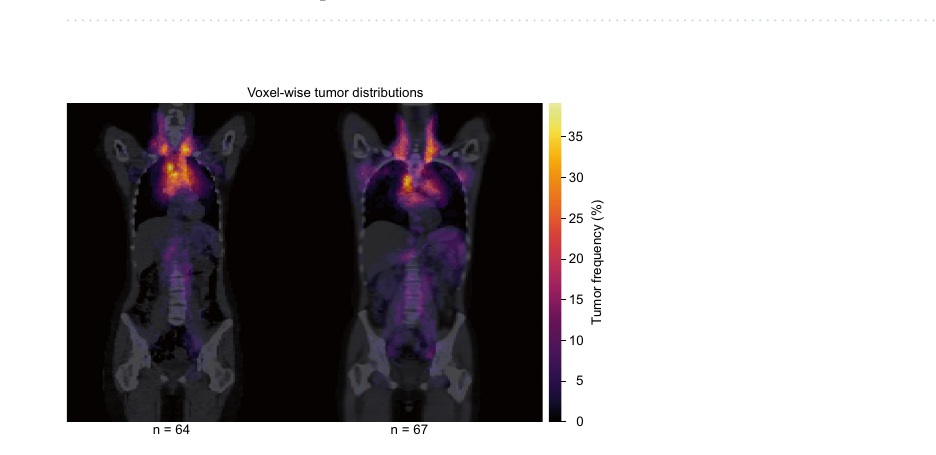
Table 2. Whole-body registration performance metrics. Values are presented on the format mean (median) ± standard deviation. VME vector magnitude error, IME intensity magnitude error, HU Hounsfield units, SAT subcutaneous adipose tissue.